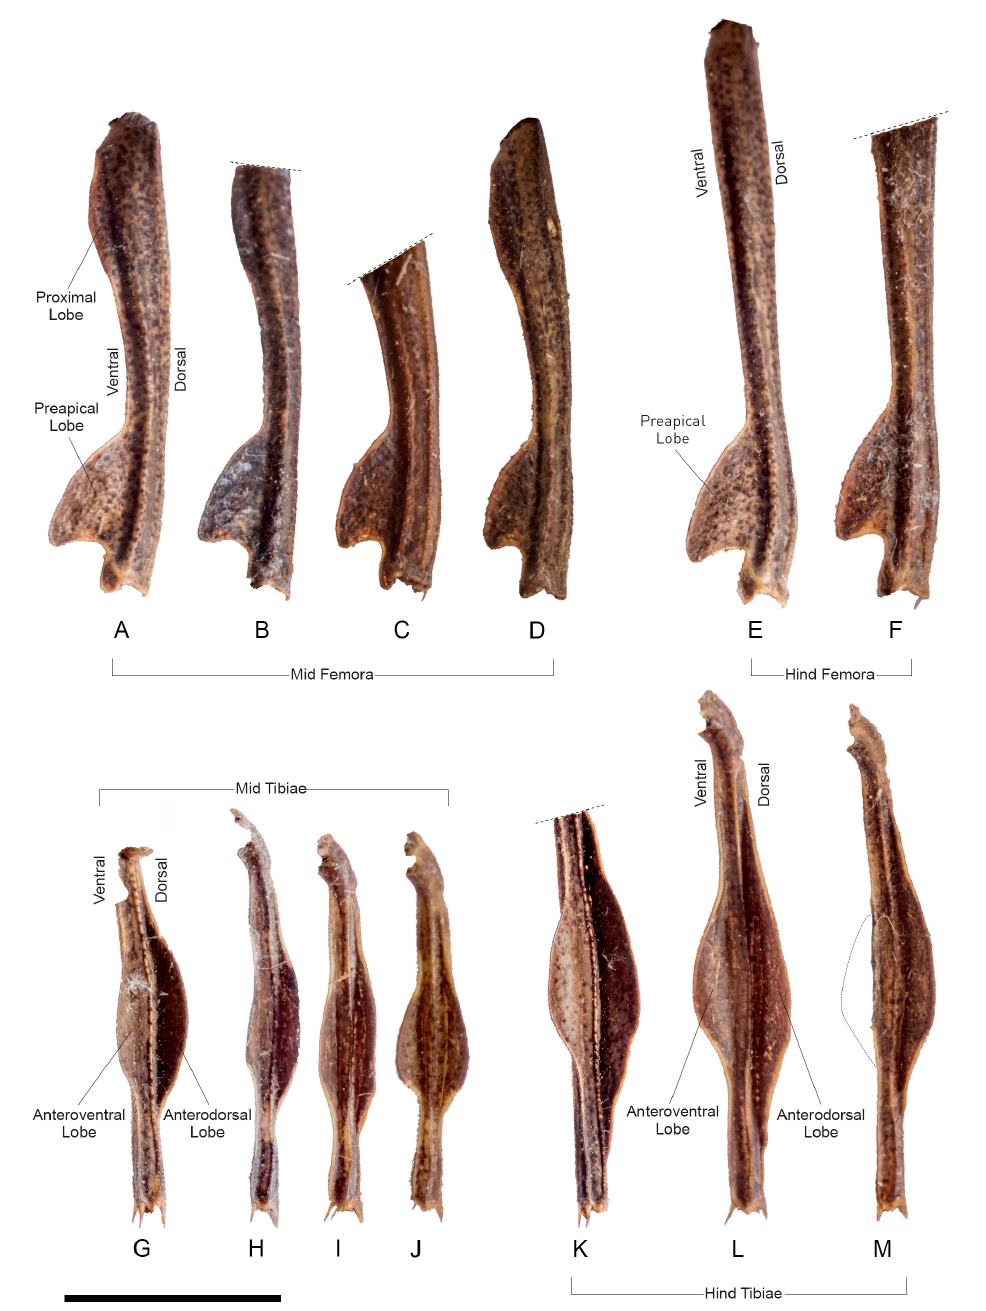
Fig. 4. Mid- and hind legs of Vates phoenix sp. nov., highlighting variation across male specimens. A – D . Mid femora. A . Holotype from Fazenda Recanto (MNRJ-ENT6-28441). B . Paratype from